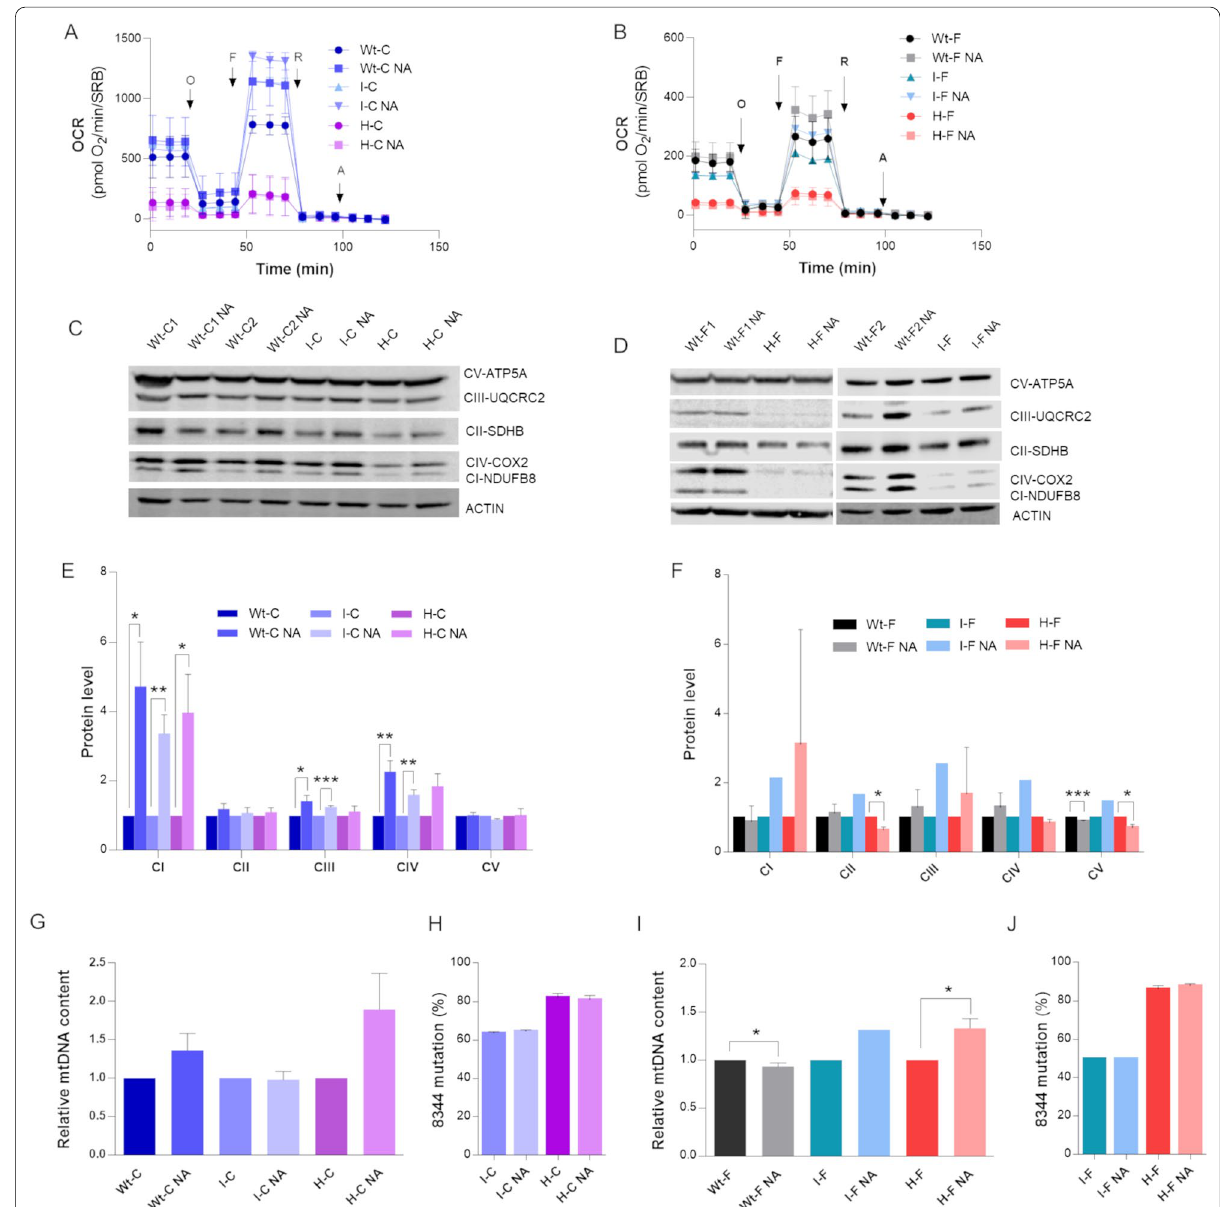
Fig. 3 Nicotinic acid (NA) treatment in MERRF cybrids and fibroblasts. Cells are treated with vehicle (DMSO) or 10 mM NA for 96 h. A , B OCR in cybrids A and fibroblasts B after NA treatment; OCR expressed as pmoles O 2 /min and normalized for protein content, under basal conditions and after injection of oligomycin (O), carbonyl cianide 4-(trifluoromethoxy) phenylhydrazone (FCCP; F), rotenone (R) and antimycin A (AA). In cybrids, data are means SD of two experiments, analyzing two biological replicates. In fibroblasts, data are means SD of three experiments for Wt-F and ± ± of two experiments for H-F; only one experiment could be performed in I-F due to spontaneous heteroplasmy shift in culturing cells. C , D Western blot of OXPHOS subunits in cybrids C and fibroblasts D ; ACTIN was used as loading control. A representative blot is shown for each protein. E Densitometry of OXPHOS subunits content in cybrids. Data of four independent experiments (biological replicates) are expressed as means and SEM, and are normalized to untreated cells. F Densitometry of OXPHOS subunits content in fibroblasts. Data are means and SD of three biological replicate for Wt-F and of two biological replicates for H-F; only one experiment could be performed in I-F due to spontaneous heteroplasmy shift in culturing cells; all data are normalized to untreated cells. G mtDNA content evaluation by qPCR in cybrids. All values are expressed as means and SEM of three biological replicates and are normalized to untreated cells. H Heteroplasmy level evaluation by snapshot method in cybrids. Values are expressed as means and SEM of three biological replicates. I mtDNA content evaluation by qPCR in fibroblasts. Data are means and SD of three biological replicates for Wt-F and of two biological replicates for H-F; only one experiment could be performed in I-F due to heteroplasmy shift in culturing cells. J Heteroplasmy level evaluation by snapshot method in fibroblasts. H-F values are expressed as means and SD of two biological replicates. Statistical analyses were performed using unpaired two-tail T-test. P value: * p < 0.05, ** p < 0.01, *** p <